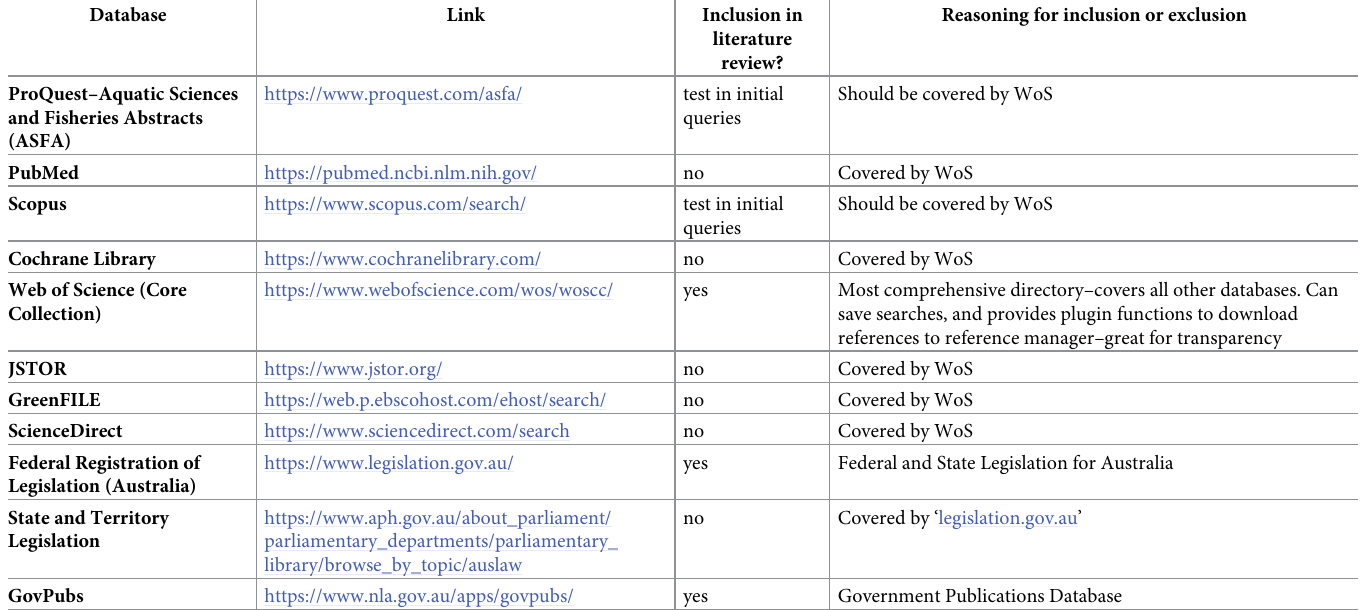
Table 2. List of academic and governmental databases searched in the systematic literature review, with internet links (accessed July